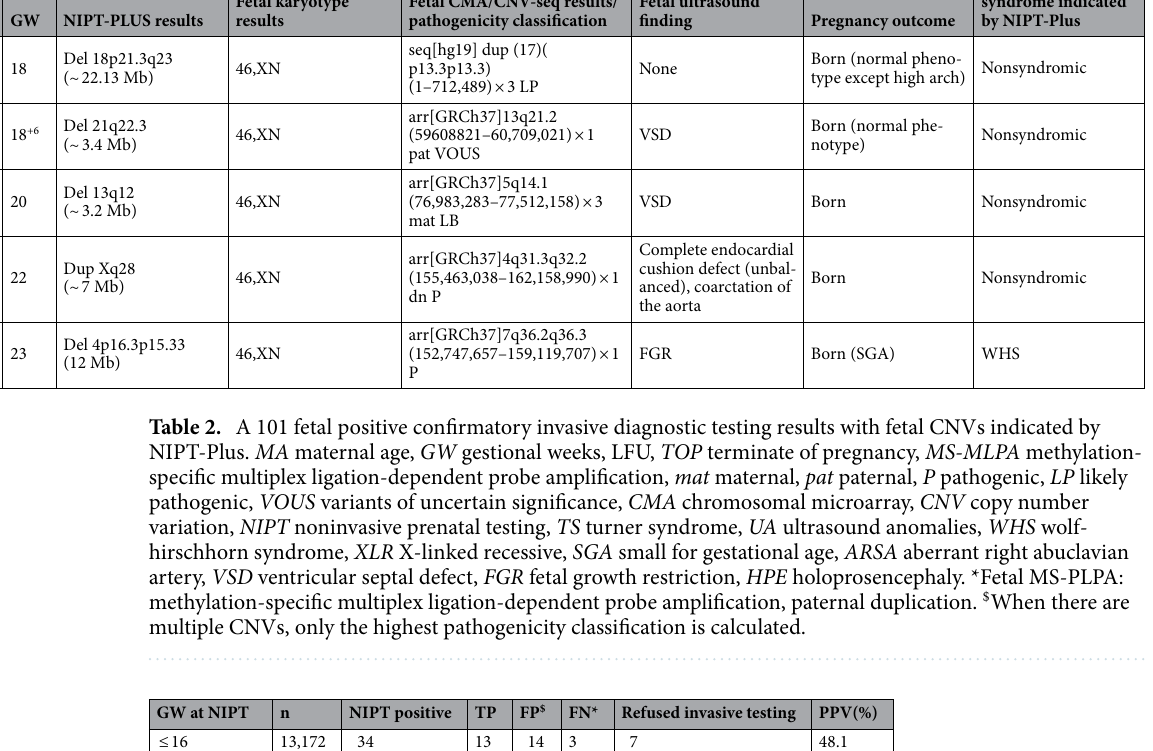
pathogenic CNV in the other two cases. CMA studies of the three placentas after induction or postpartum did not show the existence of abnormal CNVs.